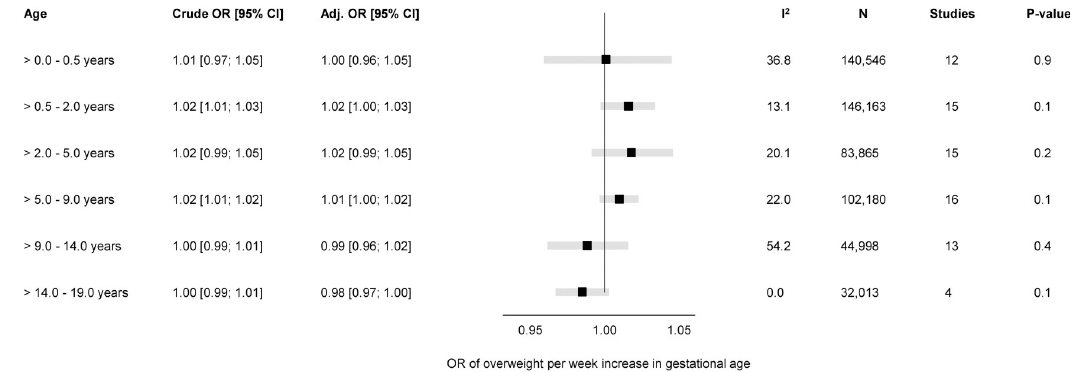
Fig 3. Forest plot of associations between GA (completed weeks) and odds of overweight. Overall unadjusted and adjusted ORs with 95% CIs from IPD meta-analyses of the study-specific logistic regression model, where cohorts were assigned weights under the random-effects model. The dot in the forest plot represents the adjusted estimates, while the whiskers span the 95% CI, whereas I 2 - statistics (I 2 ), sample size (N), studies, and p -value (two-sided, < 0.05) relate to adjusted estimates. Estimates reflect OR for overweight per week increase in gestational at birth in early infancy ( > 0–0.5 years), late infancy ( > 0.5–2.0 years), early childhood ( > 2–5 years), mid-childhood ( > 5–9 years), late childhood ( > 9–14 years), and adolescence ( > 14–19 years). Models are adjusted for sex of child, and the following maternal characteristics: age at child’s birth, education, height, prepregnancy BMI, smoking during pregnancy, parity, ethnic background, gestational diabetes and hypertension, and preeclampsia. Cohort-specific estimates were adjusted for the maximum available set of the confounding variables (see Table 1). BMI, body mass index; CI, confidence interval; GA, gestational age; IPD, individual participant data; OR, odds ratio.